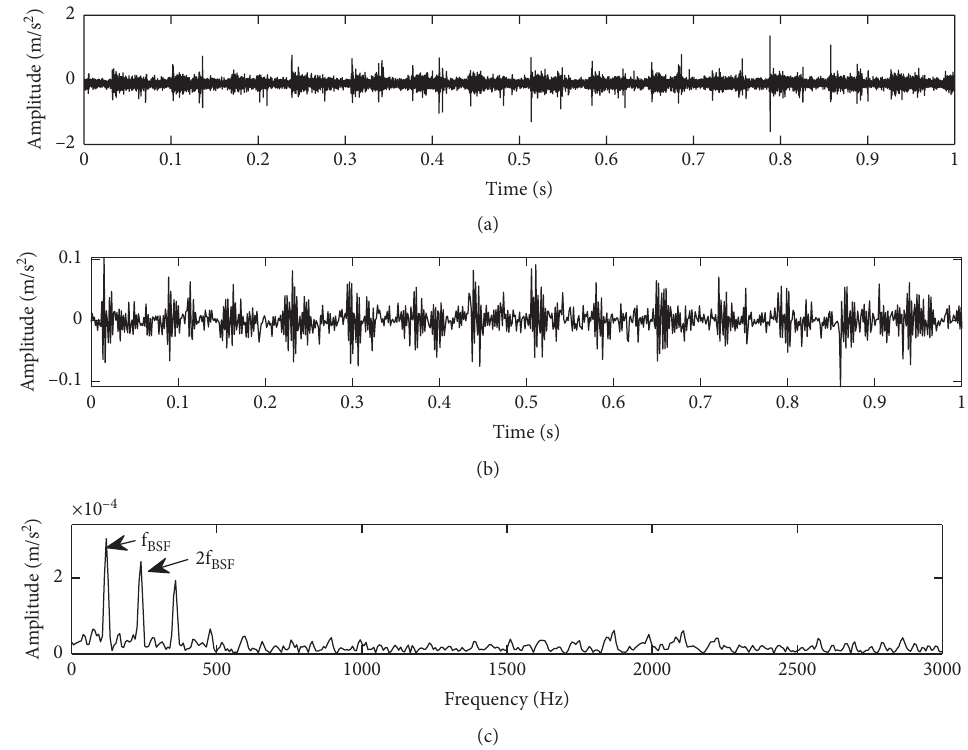
Figure 18: (a) The original signal. (b) The signal filtered by fast kurtogram. (c) The square envelope for the filtered signal.